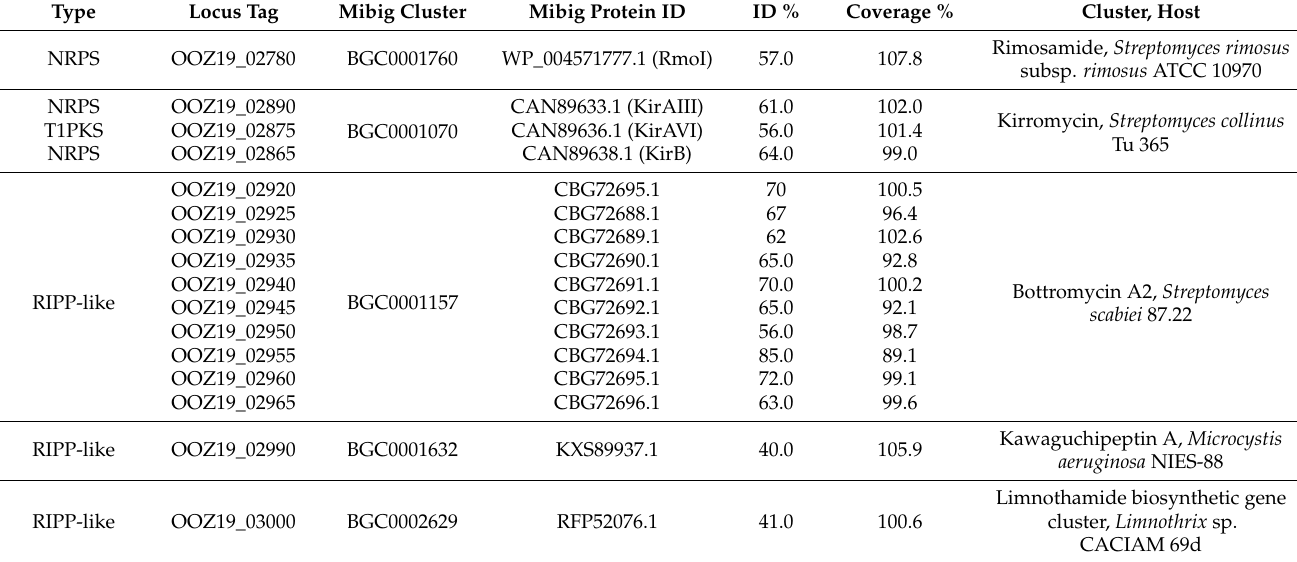
Table 2. Detailed analysis of Saccharopolyspora sp. NFXS83 hybrid biosynthetic gene cluster